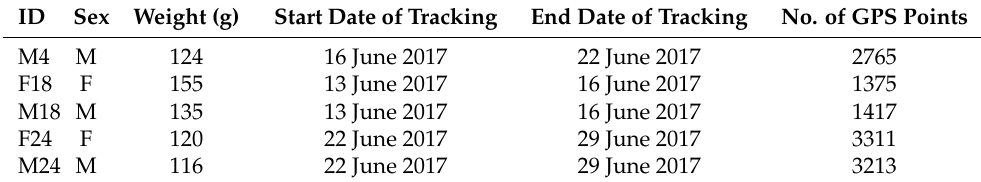
Table 1. Description of the tracked lesser